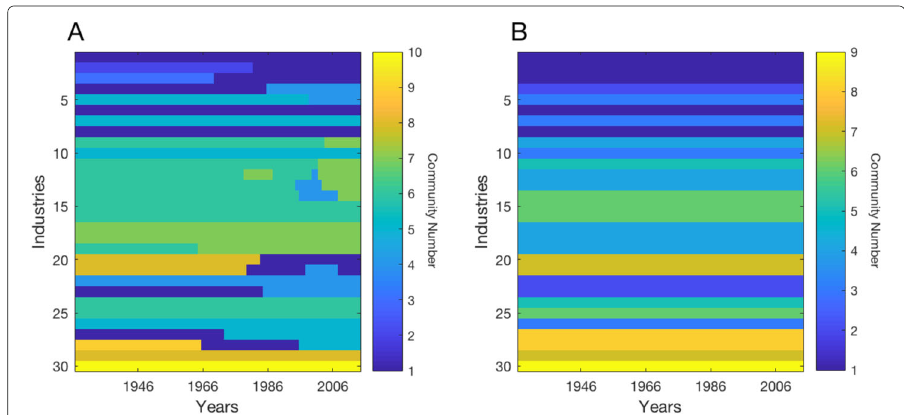
Fig. 1 CommunityAssignments:DataandNullModel. The left hand plot shows community assignments for the 30 industry portfolios over the 88 years from 1927 to 2014. This structure is constant prior to 1960, but shows substantial changes in the latter half of the sample. The right hand plot shows a representative run of the “null model”. The null model is constructed by randomizing the order of the 88 sample years, and is constant over the entire